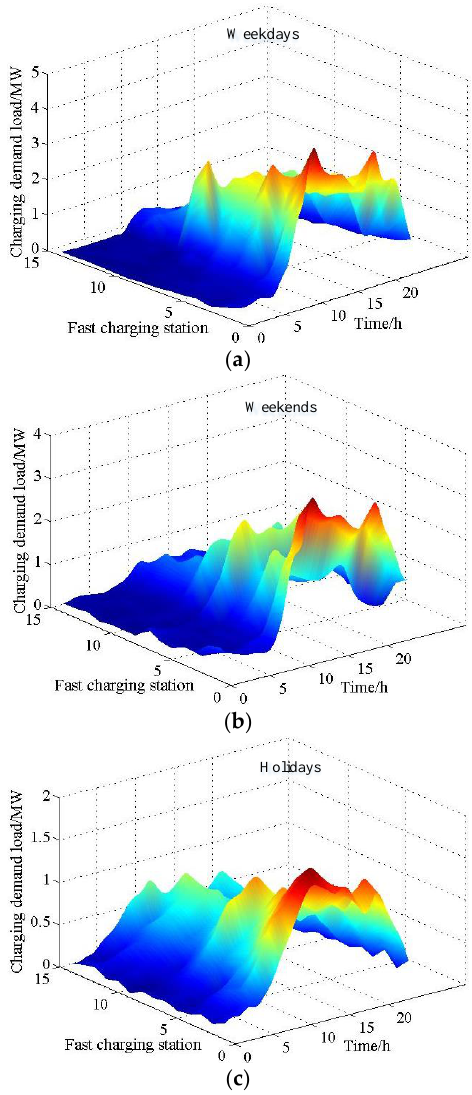
Figure 12. Charging demand load of each fast station on weekdays, weekends and holidays. ( a ) Charging demand load on weekdays. ( b ) Charging demand load on weekends. ( c ) Charging demand load on